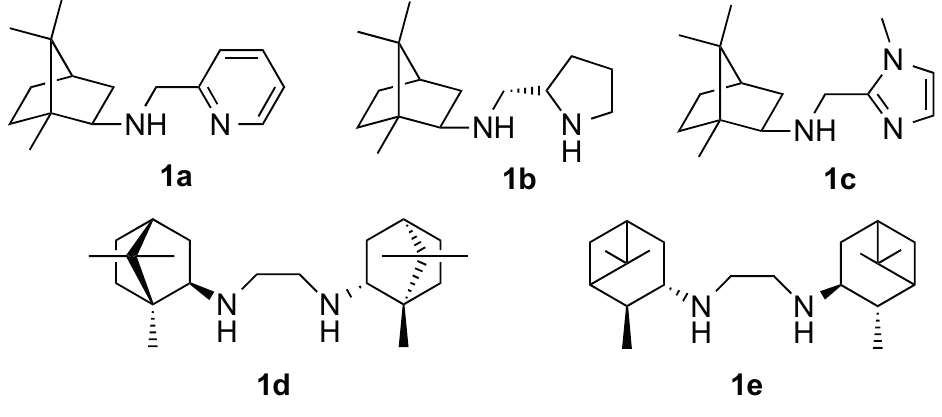
Figure 1. Some camphor and pinane-derived N , N